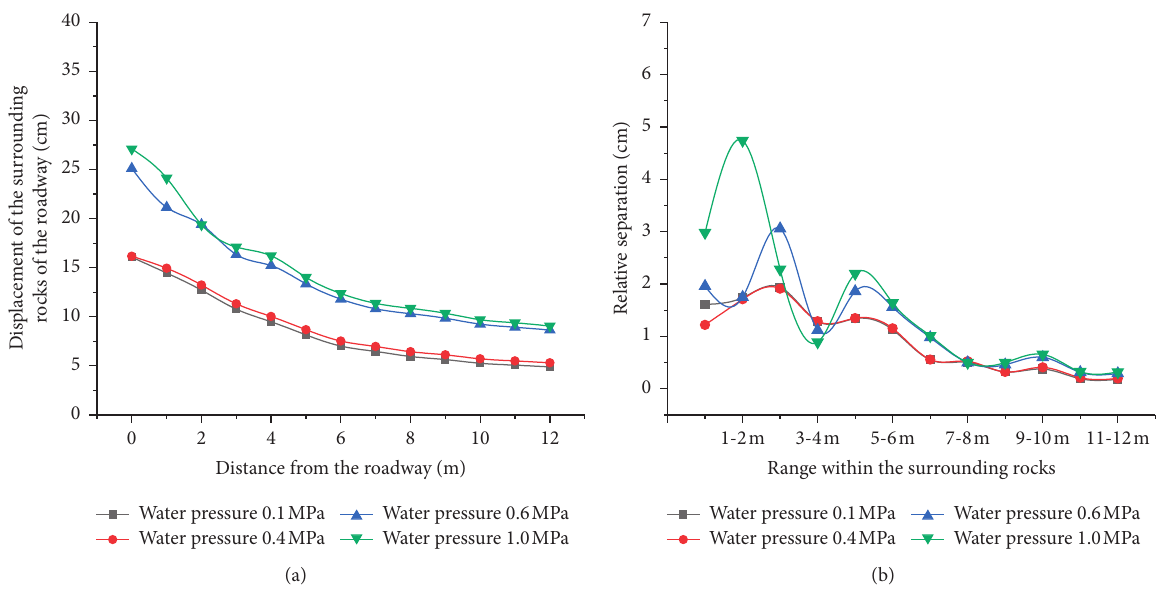
Figure 10: Variations in vertical displacement and relative separation of roof. (a) Vertical displacement of rocks surrounding the roof. (b) Relative separation of rocks surrounding the roof.